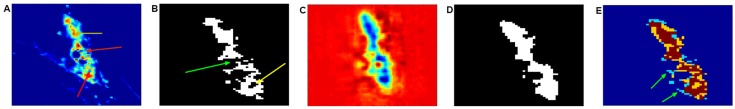
Tumour segment reconstruction from multiple channels.(A) Illustration of intensity variation for breast tumour tissue images; yellow arrows indicate a high intensity and red arrows low intensity. (B) Illustration of FCM based segmentation on (A) with inhomogeneous boundaries; yellow arrows indicate an irregular ring region and a green arrow indicates missing areas. (C) Reconstructed volume image from multiple channels. (D) Tumour segment after reconstruction. (E) Overlapped images (brown) between original tumour segment (blue) and reconstructed tumour segment (yellow). The green arrow indicates the fuzzy edges associated with the original image. The imaged tumour corresponds to an in situ ductal carcinoma.